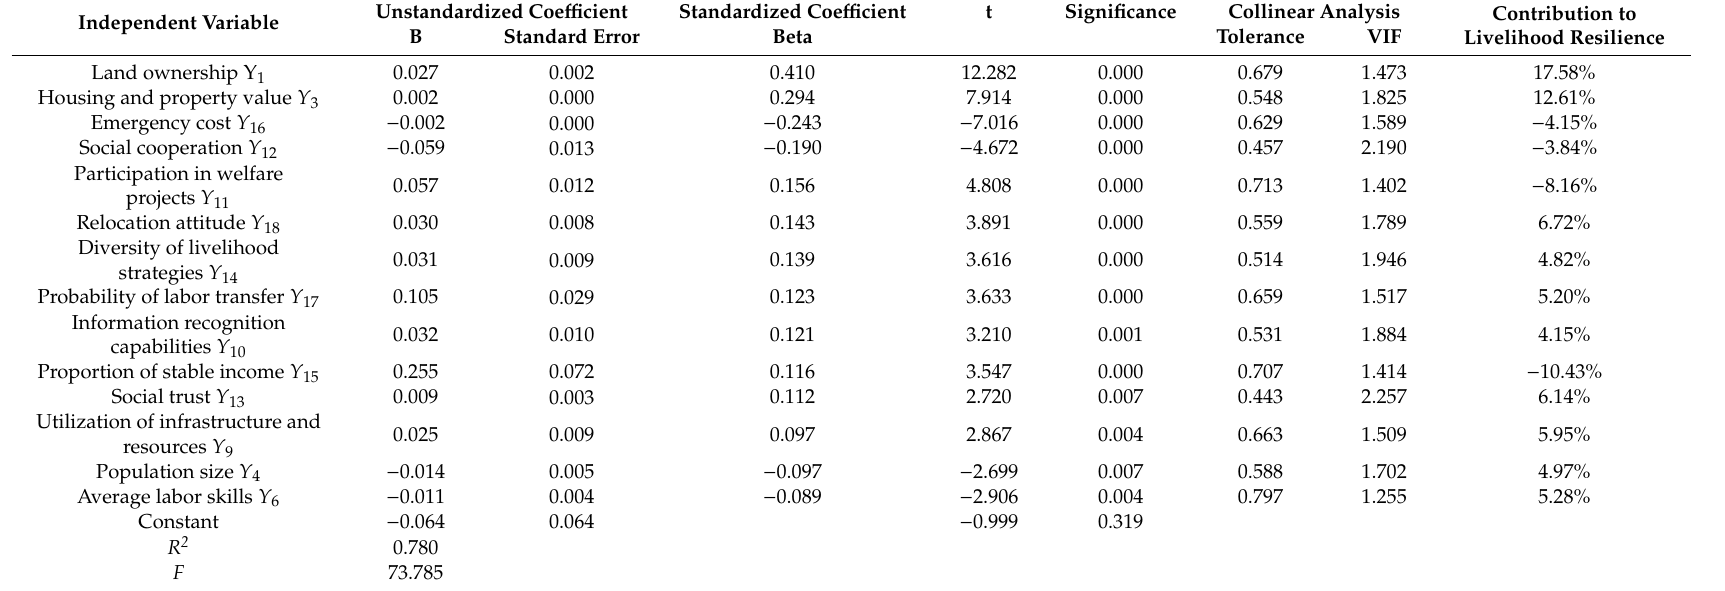
Table 4. Statistical results of multiple linear regressions on RAFs’ livelihood